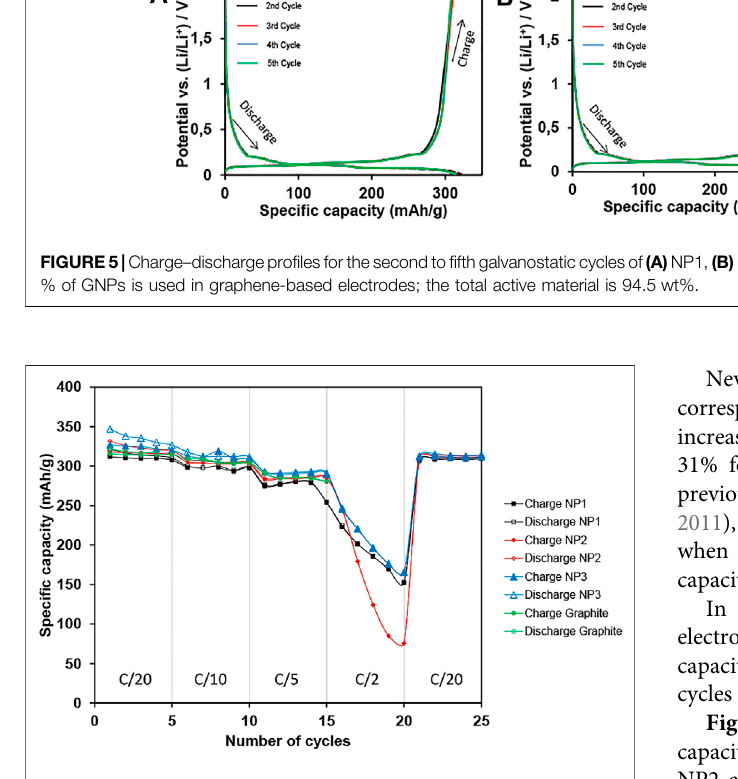
Frontiers in Chemistry |